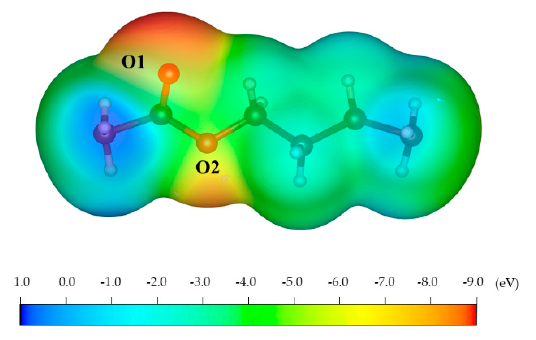
Figure 3. ESP of PCL.